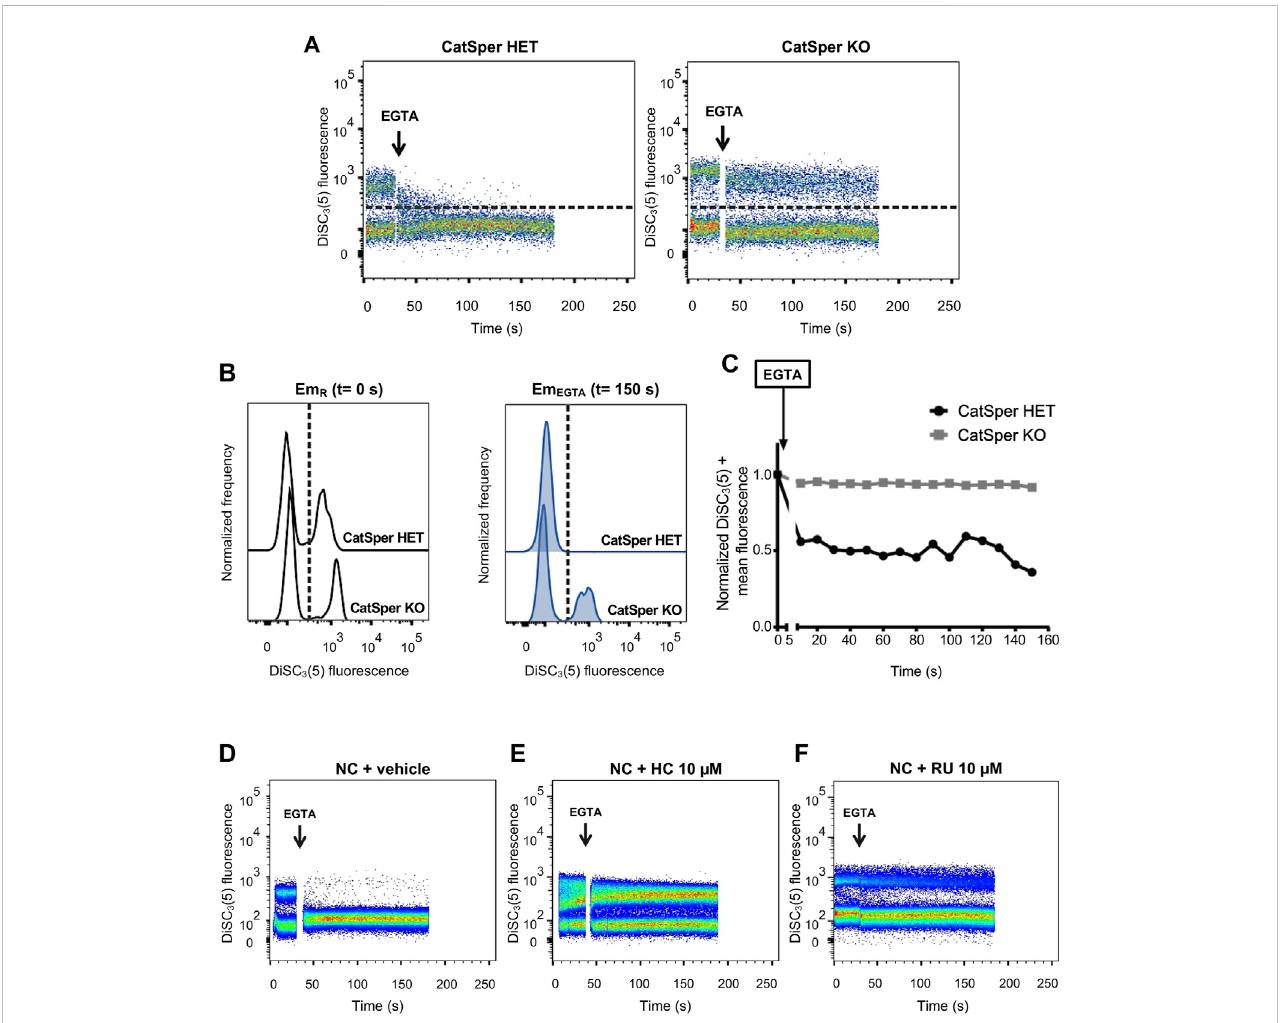
CatSper activity was assessed by measuring Em in individual live cells by fl ow cytometry, where intracellular DiSC 3 (5) fl uorescence was determined. (A) Representative 2D dot plot of DiSC 3 (5) fl uorescence vs. time (seconds)analysis, from 5 independent experiments, are shown. The addition of 3.5 mM EGTA is indicated using a black arrow. The population of sperm that responds by decreasing the fl uorescence values was established in the CatSper1 HET control conditionandusedasareferencefortheotherconditions(dashedline).Spermcellsabovethedashedline[higherDiSC 3 (5) fl uorescence]werearbitrarily identi fi ed as DiSC 3 (5) +. (B) Histogram analysis depicting normalized frequency of sperm vs. DiSC 3 (5) fl uorescence before EGTA addition (resting: Em R ) and after (Em EGTA ) were performed for both CatSper1 HET and CatSper1 KO samples. (C) DiSC 3 (5) fl uorescence mean was determined in the sperm population with higher DiSC 3 (5) fl uorescence: DiSC 3 (5) + [dashed line in (A) ] before (time = 0 s) and after (black arrow) addition of 3.5 mM EGTA. In each condition, the fl uorescencemeanwasnormalizedtothebasal fl uorescence(0 s). (D,F) Representative2DdotplotofDiSC fl uorescencevs.time(seconds)analysisinthe 3 (5) absence or presence of pharmacological CatSper blockers. The addition of 3.5 mM EGTA (black arrow) provokes a decrease in the population of sperm with high DiSC 3 (5) fl uorescence due to Em depolarization in the control condition (D) but not in the presence of 10 µM HC-056456 (E) or 10 µM RU 1968 (F)